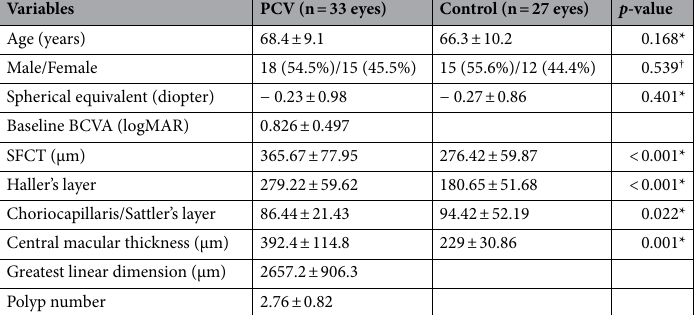
Table 1. Baseline characteristics of the PCV patients and normal controls. BCVA best-corrected visual acuity, logMAR logarithm of the minimum angle of resolution, PCV polypoidal choroidal vasculopathy,